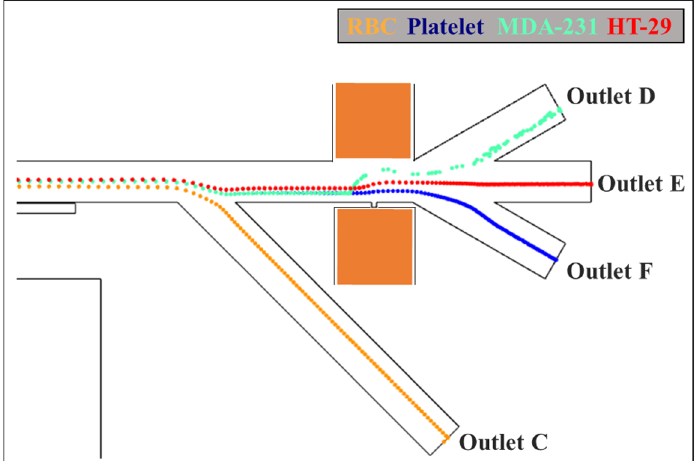
Figure 8. Numerical simulation of the separation of RBCs, MDA-231, HT-29, and platelets. The voltage of 11 V is applied at the small orifice and the large orifice is grounded. The residual magnetic flux density is 1 T. The frequency of the electric field is 10 4 Hz and the velocity of the cells is 300 µ m/s. The width of the main channel is 80 μ m. The width and length of the small orifice are 10 μ m, and the width of the large orifice is 100 μ m.